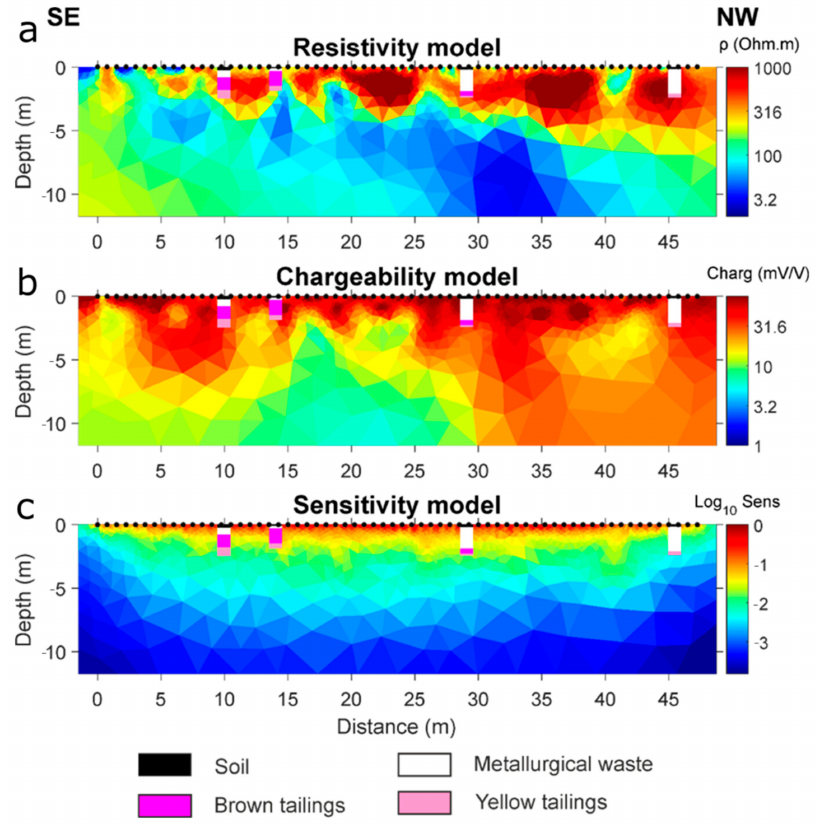
Figure 5. Inversion results for P2: ( a ) electrical resistivity model, ( b ) chargeability model and ( c ) normalized sensitivity model. The electrodes are represented by black circles. Drill holes conducted in the vicinity of the profile are also displayed for validation. Charg—Chargeability,